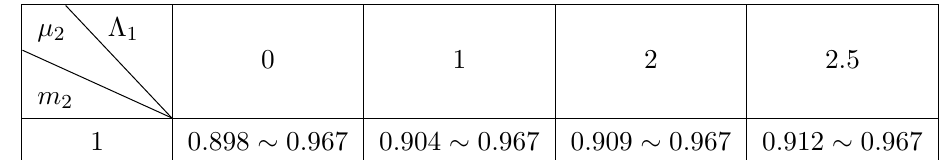
Table 2 . The domain of existence of the mass µ 2 of the scalar field φ 2 with various values of the coupling parameter Λ 1 . All solutions have µ 1 = 1 , m 1 = 1 , and m 2 = 1 . respectively. In the inset panel, we show the detail of the blue shaded area with m